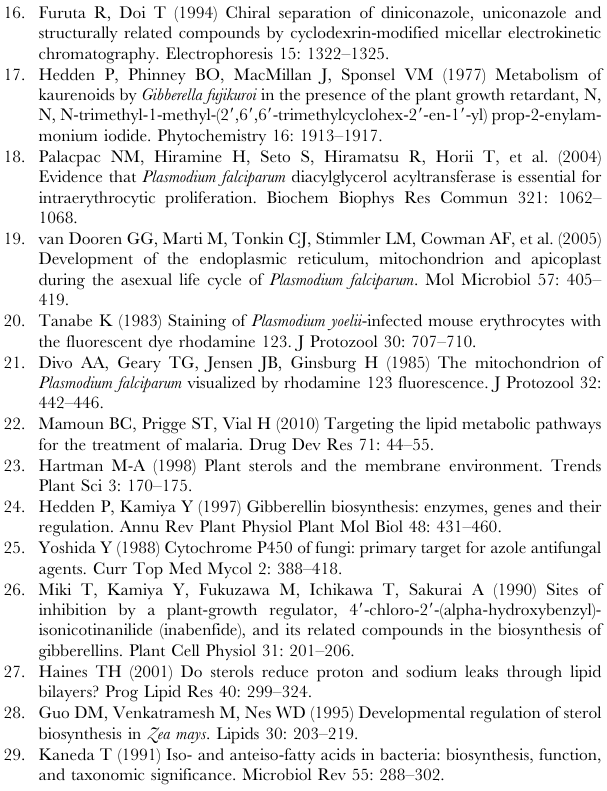
the counter was blinded to sample identities. Error bars represent the standard deviation of three independent experiments made in duplicate. Data are normalized relative to those for the control treated with 1 6 PBS and 1 m l/ml DMSO. (TIF) Figure S7 Influence of Ca 2 + on the effects of INA in P. falciparum . Parasites were synchronized by 5% sorbitol treatment and treated with 1 m l/ml DMSO or 50 m M INA with or without adding 100 m M CaCl 2 after 18 h of incubation. The parasites were examined at 6 h of the treatment by thin blood smears and staining with Giemsa. Scale bar indicates 3 m m. Each panel shows a typical morphology of trophozoite-stage parasites in each treatment.